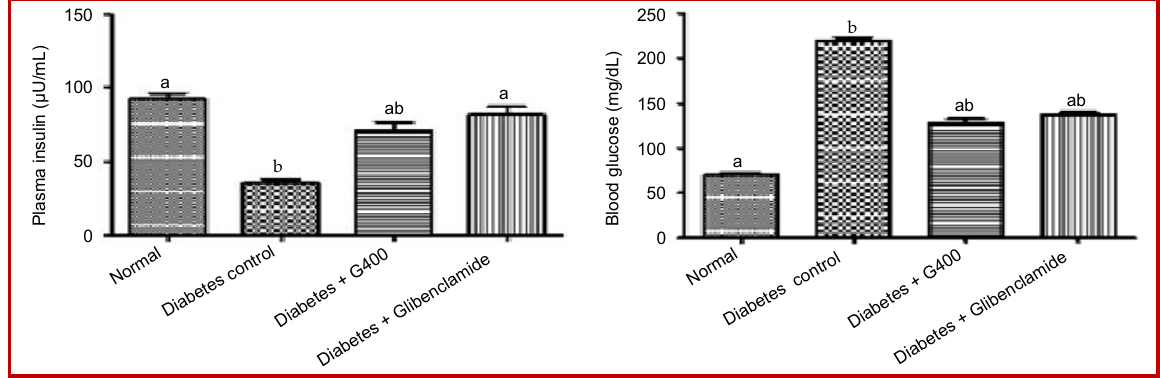
Figure 1: Effect of G-400 on the plasma glucose and insulin levels on streptozotocin treated rats Streptozotocin-treated diabetic rats were treated with G-400 (100 mg/kg b.wt.) daily using an intragastric tube for 4 weeks. The results were com- pared with diabetic control rats (group 2) and normal control (group 1), where no STZ was administered. The positive control in the study comprises of rats administered with glibenclamide (0.025 mg/kg b.wt.) daily using an intragastric tube for 4 weeks. Results are expressed as mean ± SD of n = 4-6 independent assays. b p<0.05, statistically different from the control group, a p<0.05, statistically different from diabetic